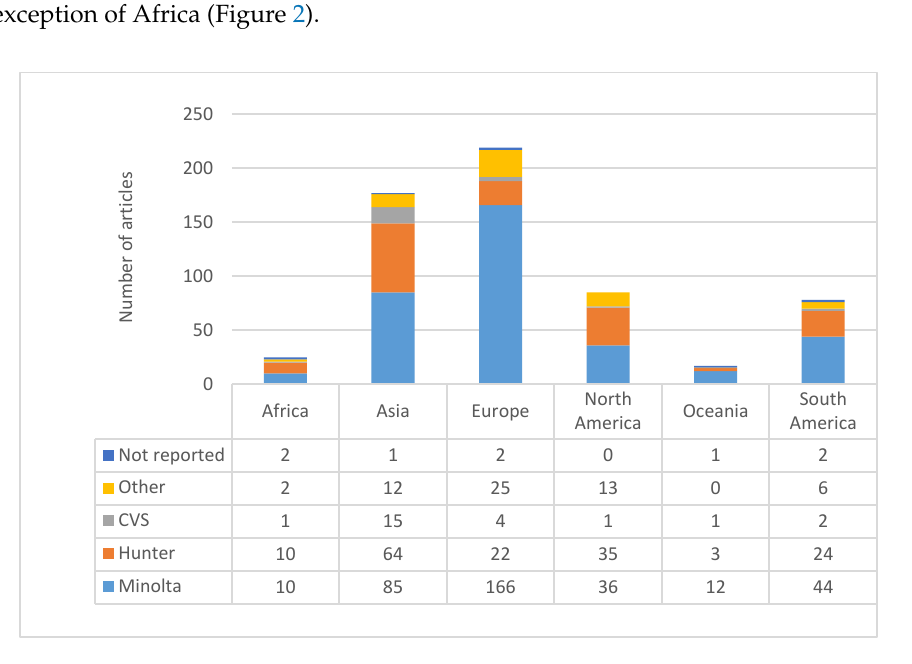
Figure 2. Interaction of countries with type of device for milk color assessment.